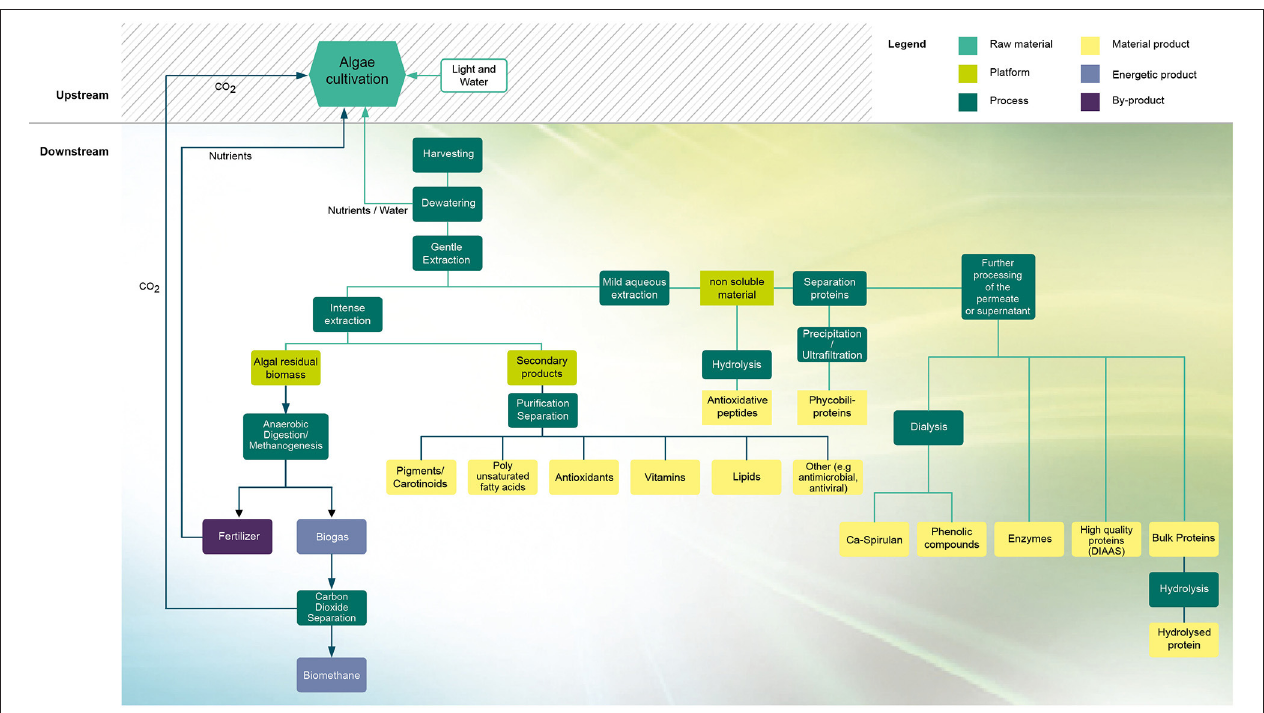
FIGURE 1 | Biorefinery model for microalgae processing. Adapted from Mathys et al. (42). © 2013 Alexander Mathys All Rights